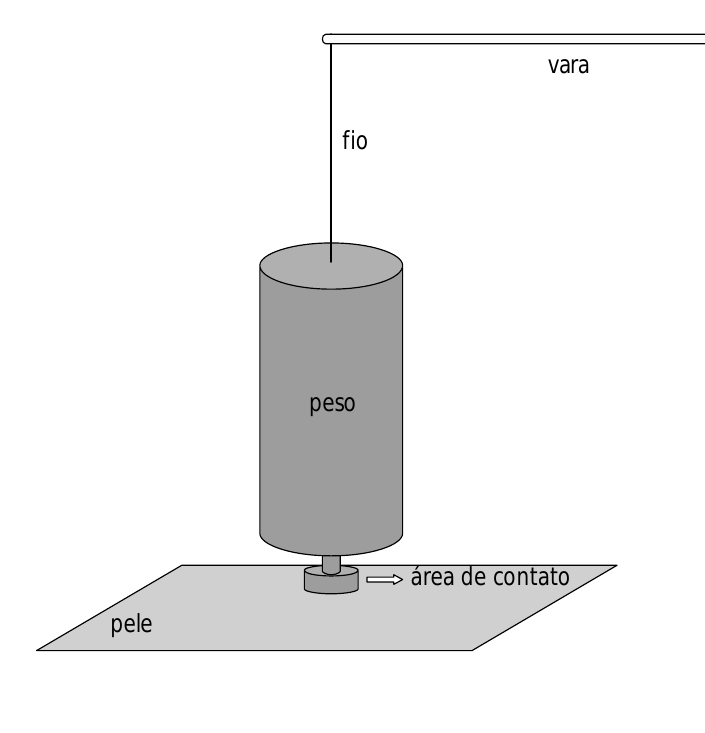
FIGURE 3 : Diagram showing the device used to test sensibility to